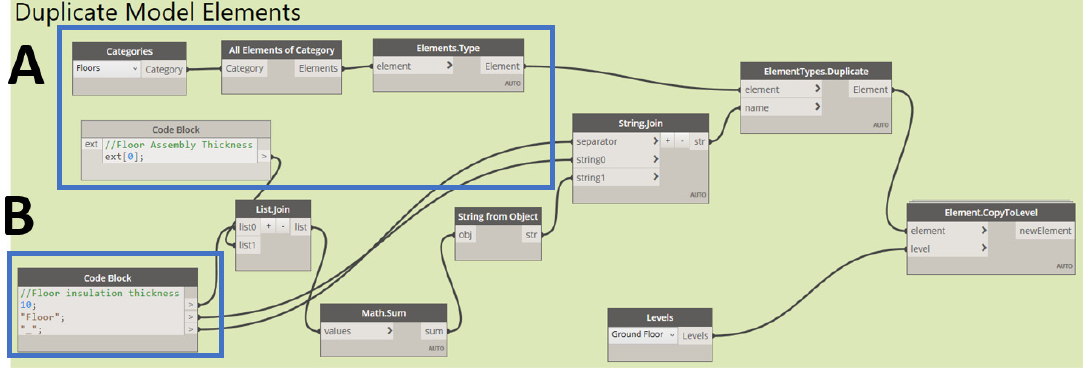
Figure 7. Dynamo Workflow for Duplicating and Renaming Model Element. ( A ) floor assembly thickness; ( B ) floor insulation thickness determined by the designer.